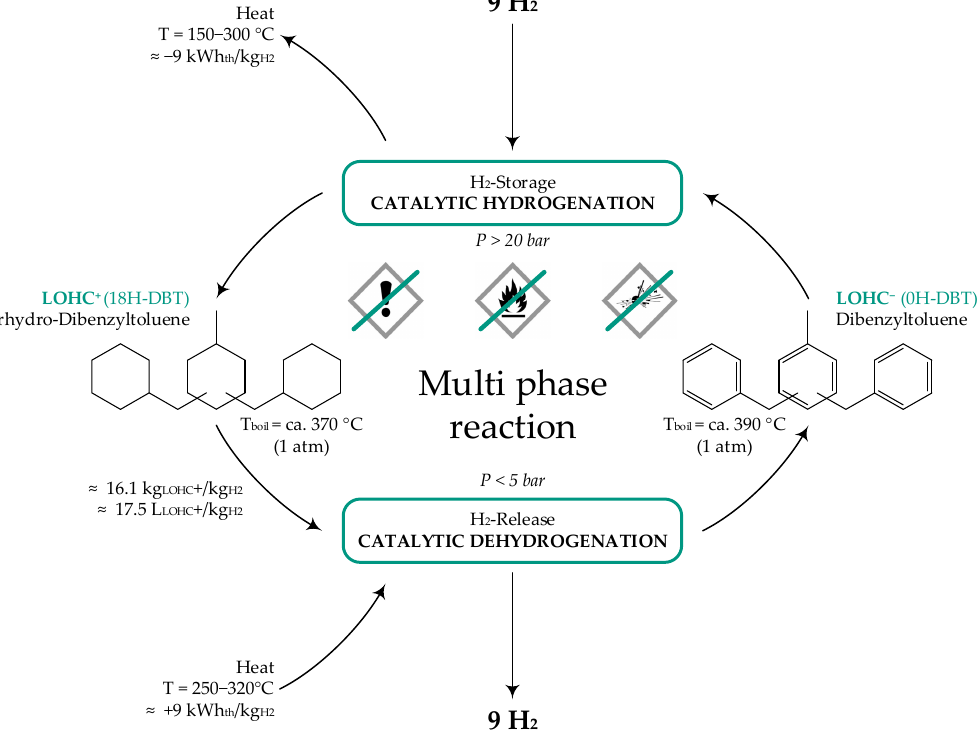
Figure 1. Scheme of the cycle of an organic liquid hydrogen carrier (LOHC) molecule, in this case dibenzyl-toluene, including its properties, adapted from [5].